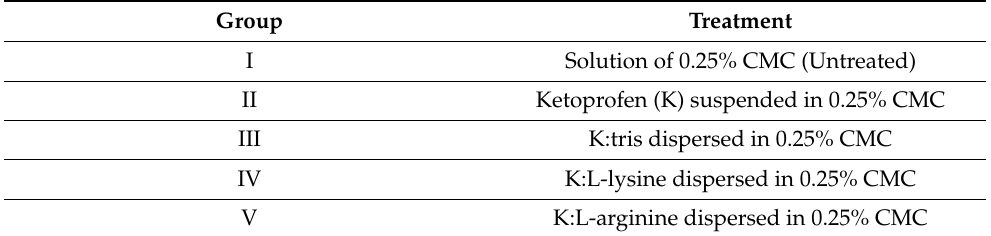
Table 1. Different groups and treatments received in the writhing